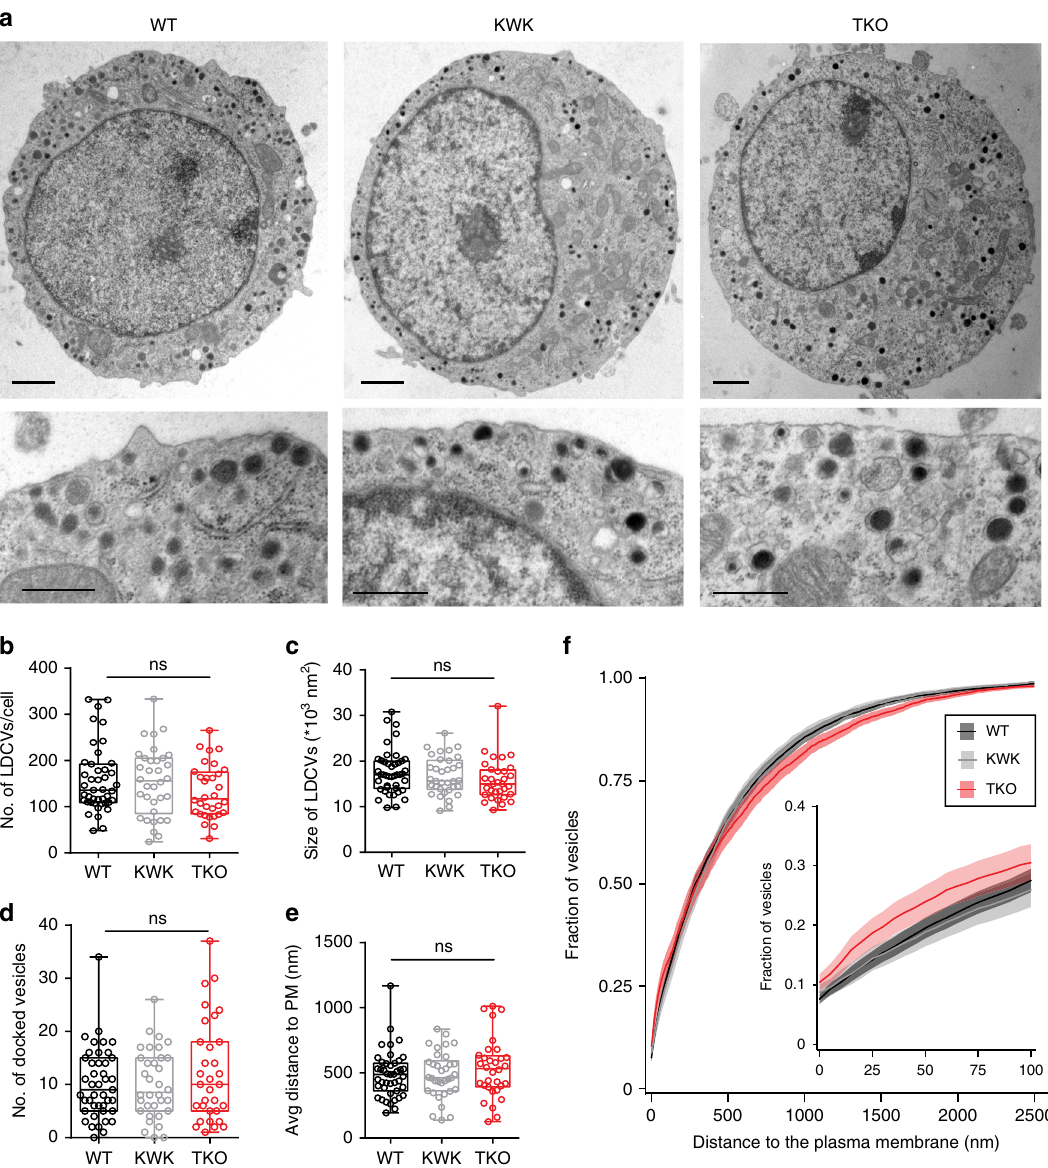
Fig. 3 Number, distribution, and size of LDCVs were not altered in endophilin TKO chromaf fi n cells in culture. a Typical electron micrographs of WT, endophilin KWK (littermate control) and endophilin TKO chromaf fi n cells in dissociated culture. Bottom row shows the sub-plasma membrane area at higher magni fi cation. Scale bar: 1 µ m (top row) and 0.5 µ m (bottom row). b Total number of vesicles/cell cross section, c surface of the vesicle projection, d number of docked vesicles/cell cross section and e the average distance of vesicles to the plasma membrane in dissociated chromaf fi n cell cultures. Bar shows mean, error bars SEM, dots are individual measurements. f Relative cumulative distribution of vesicles to the plasma membrane in 5 nm bins. Insert shows the distribution pro fi le in the fi rst 100 nm, line shows average, ribbon shows SEM (Kolmogorov – Smirnov test with Bonferroni-correction). a – f Three independent experiments, four mice each, cells WT (43), KOWTKO (34), and TKO (32). One-way ANOVA after Tukey ’ s post-hoc test, ns not signi fi